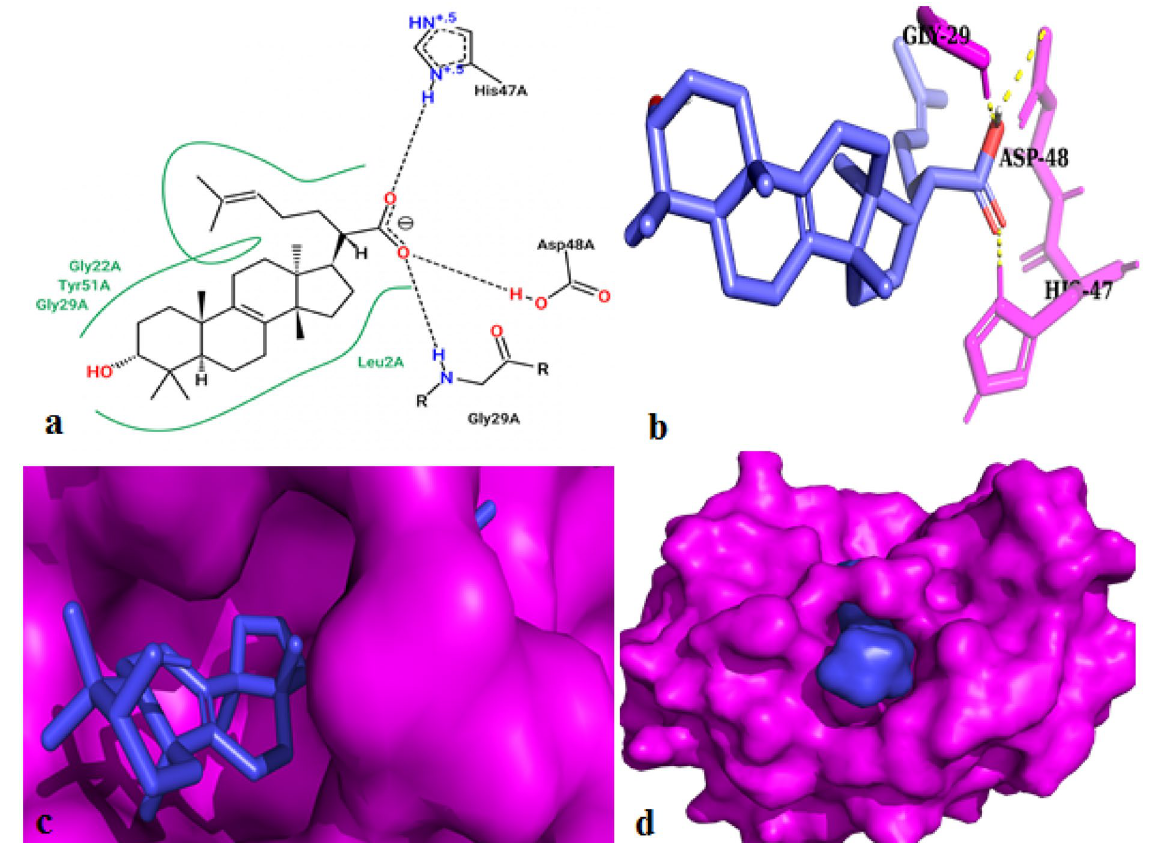
Figure 3. Docked images of GIIA (1POE) with elemolic acid. Stereoview of elemolic acid docked in the active site of GIIA. ( a ) Interaction between the active site amino acids of GIIA with elemolic acid and hydrophobic interaction with substrate-binding pocket; ( b ) Sticks display mode; ( c , d ) Space filled display modes were obtained from PyMol, Autodock Vina, and pose View (http:// posev iew. zbh. uni- hambu rg. de/ posev iew). Hydrogen bonds are presented by the dashed